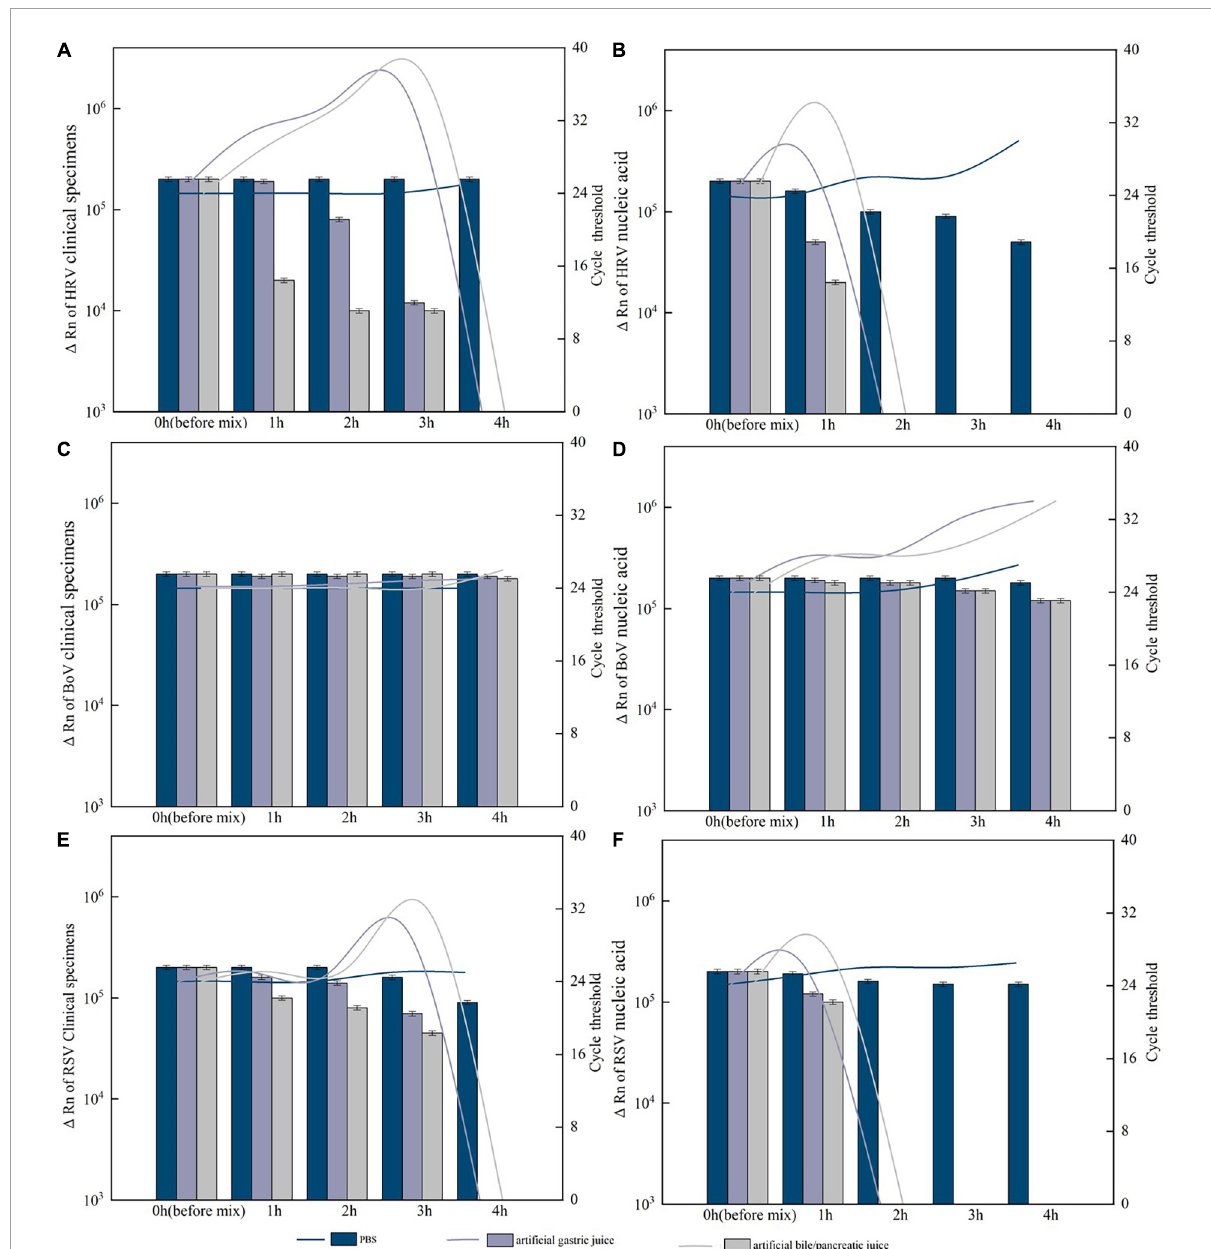
FIGURE7 Resistance of the positive specimens and nucleic acids of respiratory viruses to artificial digestive juice (artificial gastric acid and bile/pancreatic juice). (A) Resistance of the human rhinovirus (HRV) positive specimens to artificial digestive juice; (B) resistance of the HRV nucleic acids to artificial digestive juice; (C) resistance of the Bocavirus (BoV) positive specimens to artificial digestive juice; (D) resistance of the BoV nucleic acids to artificial digestive juice; (E) resistance of the respiratory syncytial virus (RSV) positive specimens to artificial digestive juice; and (F) resistance of the RSV nucleic acids to artificial digestive juice. Virus RNA copy number ( (cid:49) Rn) was shown by bar charts, and cycle threshold (Ct) was shown by line charts.